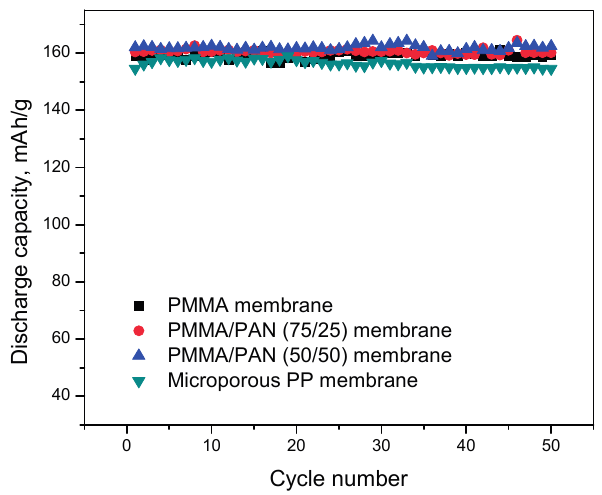
Figure 7. Cycling performance of Li/LiFePO 4 cells containing PMMA membrane, PMMA/PAN (75/25) membrane, PMMA/PAN (50/50) membrane, and microporous PP membrane at 0.2 C.